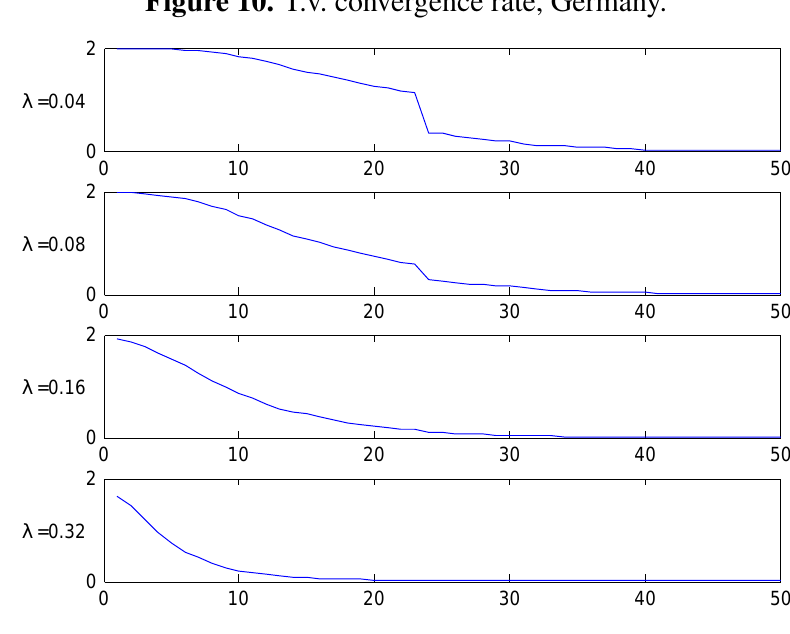
Figure 10. T.v. convergence rate, Germany.